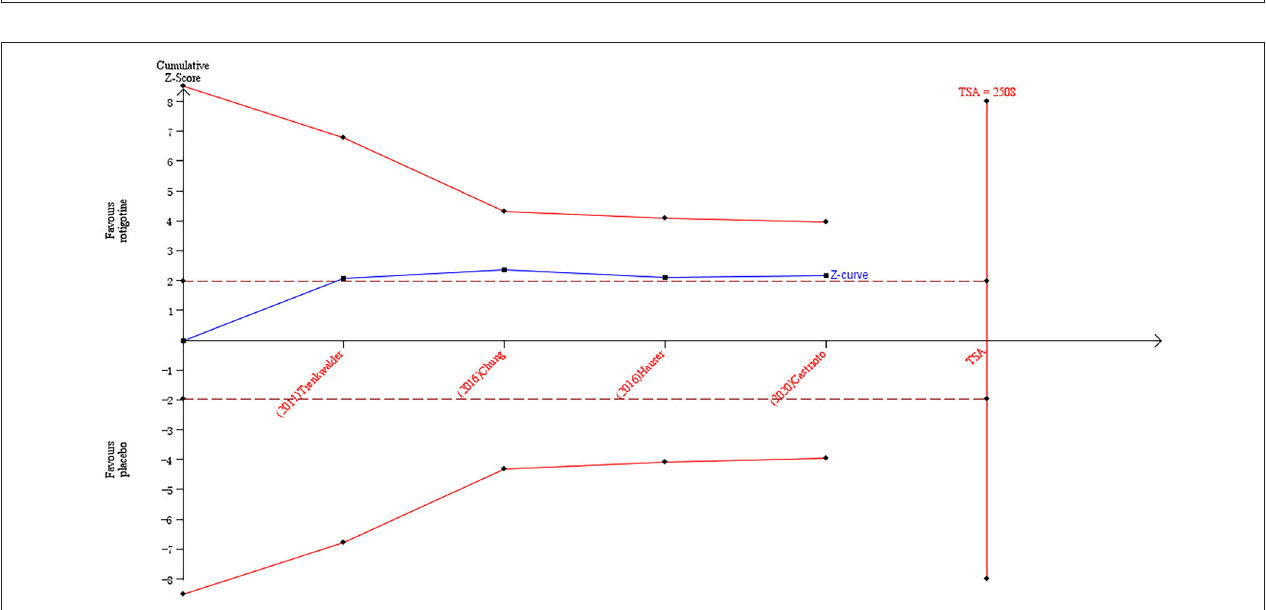
FIGURE 3 | Trial sequential analysis of the cumulative meta-analysis of the effect of rotigotine vs. placebo on Apathy Scale score in Parkinson’s disease patients.